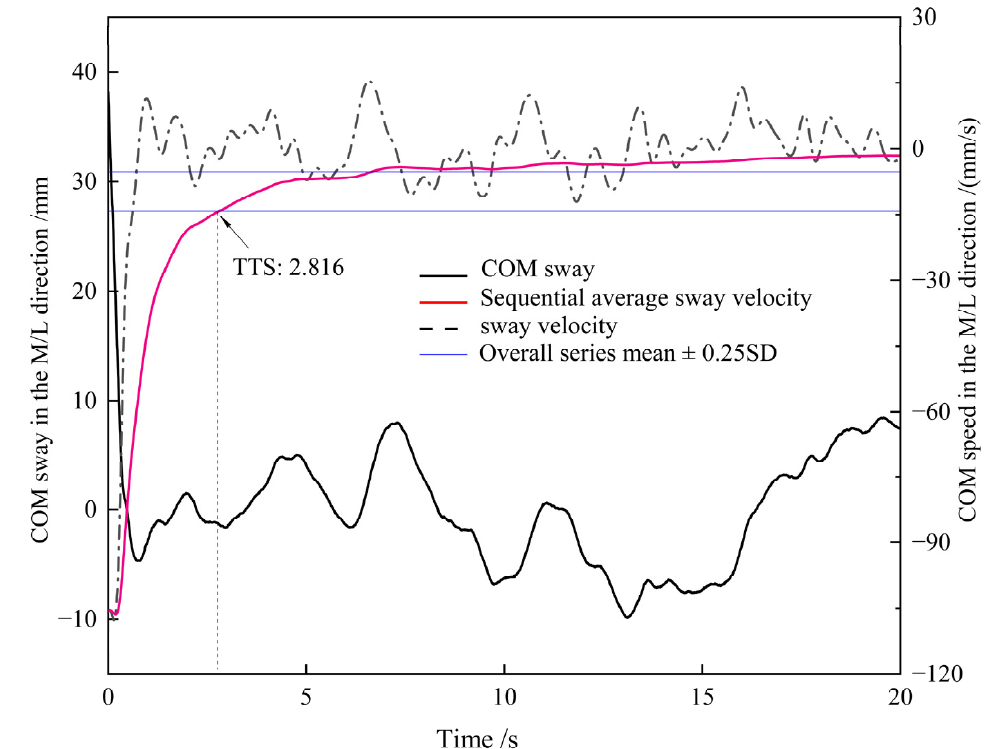
Figure 4. Interpretation diagram of COM velocity for a single trial. TTS: time to stabilization, COM: center of mass, SD: standard deviation, M/L: mediolateral.